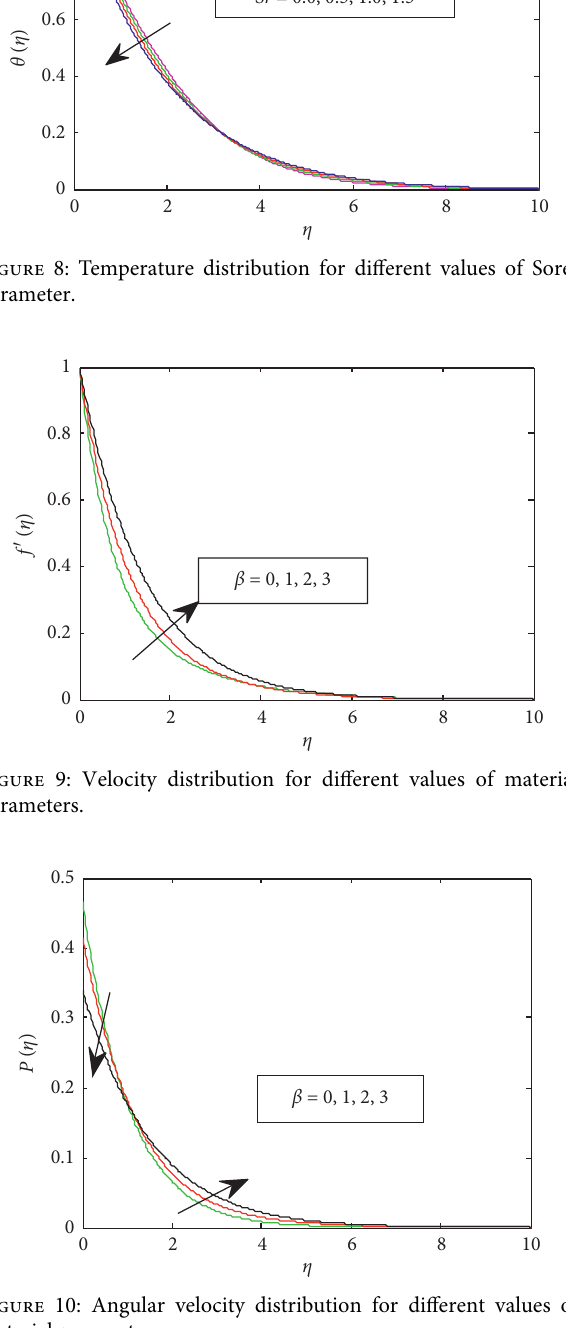
Figure 7: Concentration distribution for different values of Soret parameter.